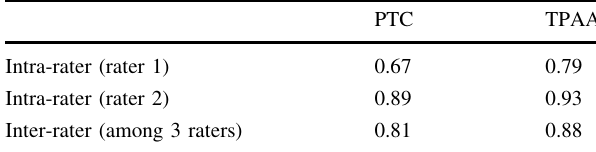
Table 5 Intra-rater (test–retest) reliability and inter-rater reliability (measured by intraclass correlation coefficient — ICC) for posterior tibial cortex (PTC) and tibial proximal anatomical axis (TPAA) methods obtained by repeated measurements in 50 random